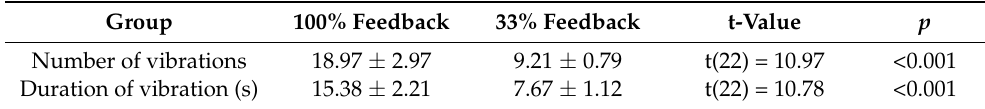
Table 4. Group means ( ± standard deviation) and statistics (i.e., t and p values) for the number and duration of tactile vibrations for the sham